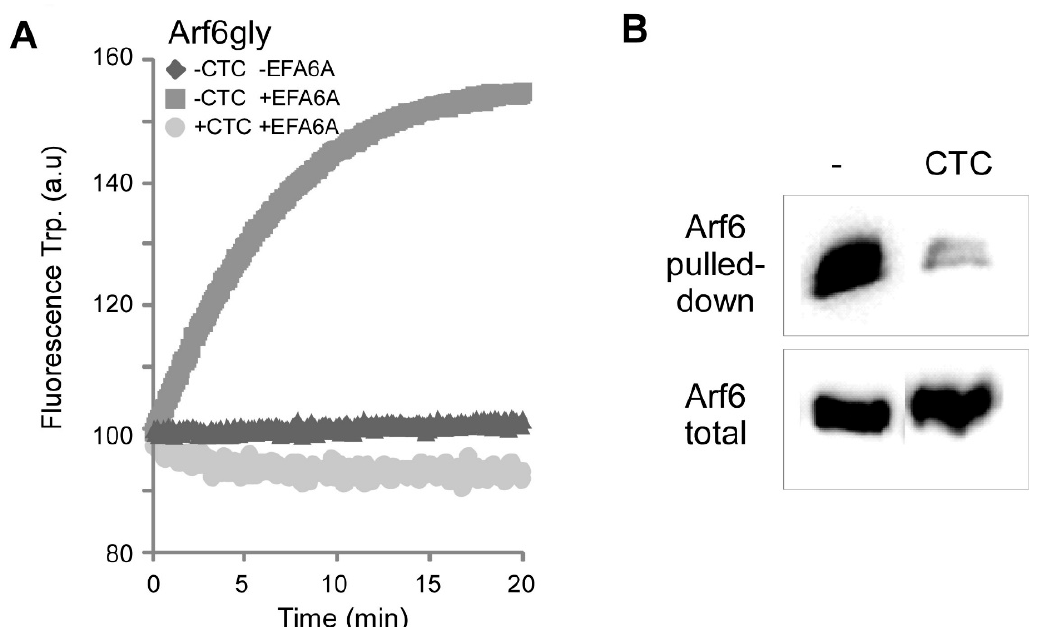
Figure 4. CTC blocks the Arf6GTP-induced change of conformation. ( A ) GTP (250 µM) loading on Arf6gly (1 µM) was monitored by tryptophan fluorescence (Ex: 297 nM, Em: 340 nM) at 25 °C with 0.2 g/L azolectin and with or without EFA6A (250 nM) and CTC (100 µM). ( B ) Arf6GTP binding to ARHGAP10 was carried out by a GST pull-down experiment as described in Methods.